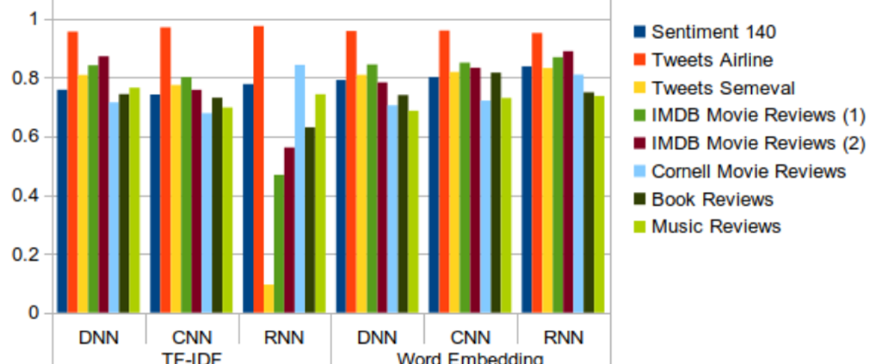
Figure 17. Recall values of DNN, CNN, and RNN models with TF-IDF and word embedding for different datasets. Table 4. The precision comparison for different datasets.